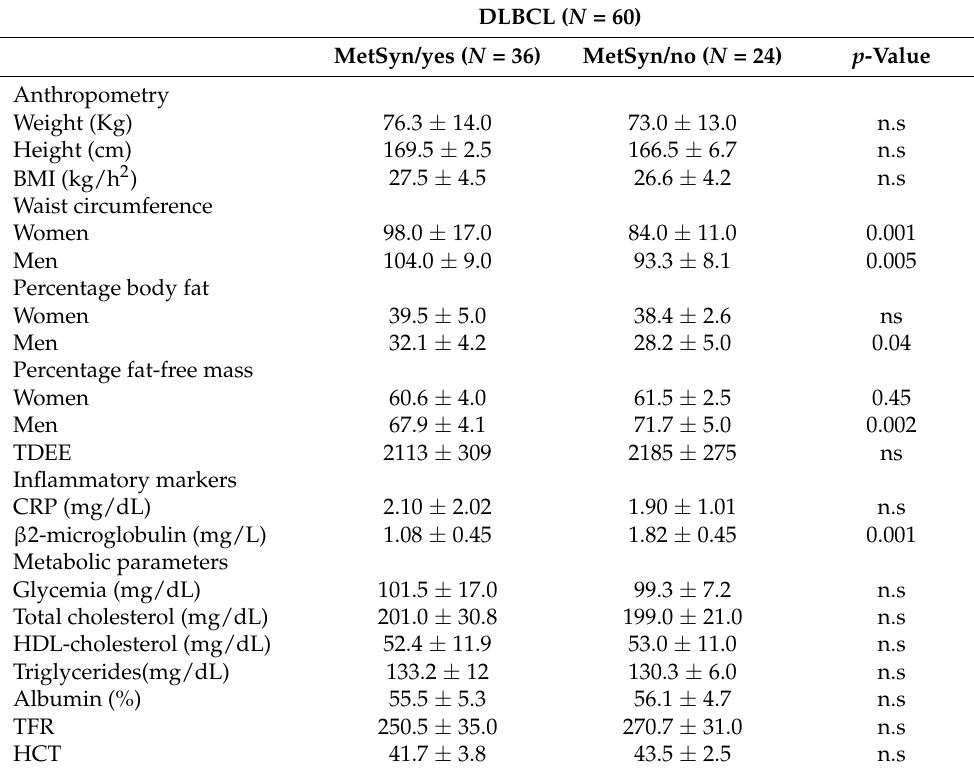
Table 2. Mean value comparison between anthropometric and metabolic parameters in non- Hodgkin’s lymphomas (NHL) patients with or without metabolic